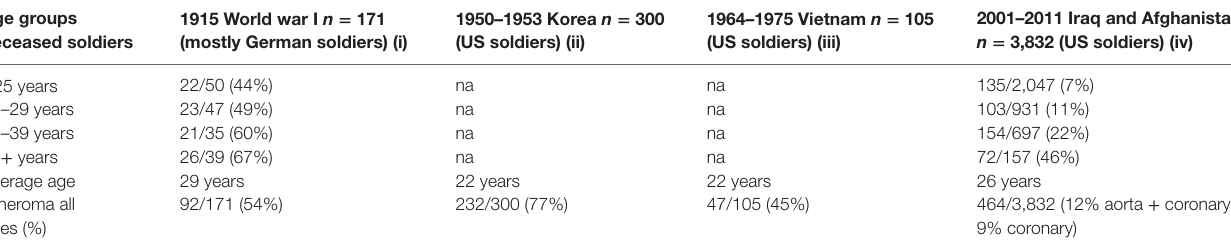
TABle 1 | Prevalence of atheromatous coronary artery disease in young western soldiers (over 98% males) killed in world war i, Korea, vietnam, iraq, and Afghanistan (9–12). Age groups deceased